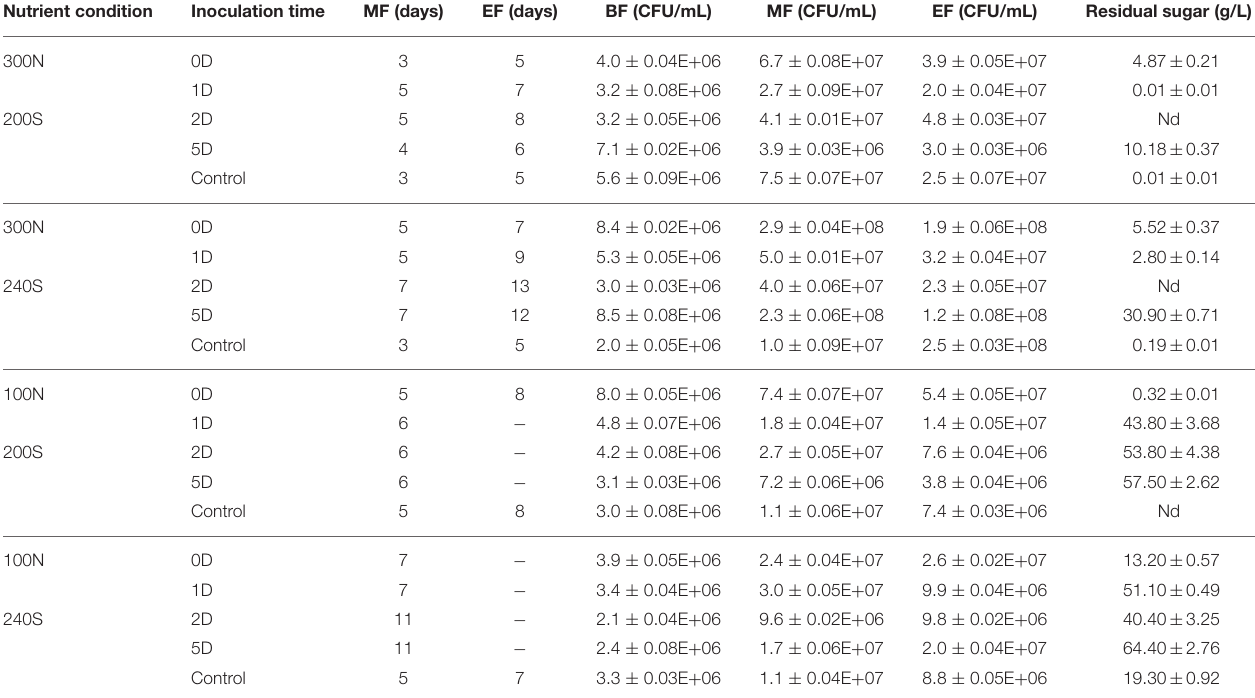
TABLE 1 | Evolution of the different fermentations (0D, co-inoculated fermentation; 1D, inoculation of S. cerevisiae at 24h; 2D, inoculation of S. cerevisiae at 48h; 5D, inoculation of S. cerevisiae at 5 days; and Control, only S. cerevisiae ) under four nutrient conditions (300N-200S, 300N-240S, 100N-200S, and 100N-240S).